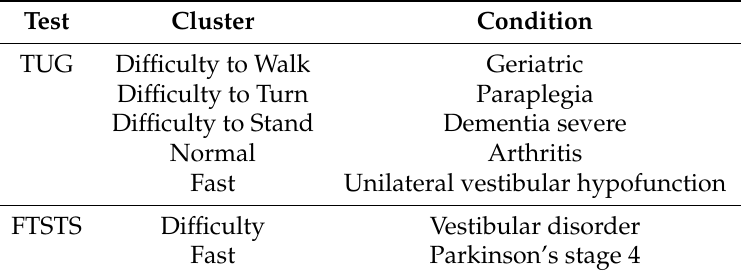
Table 4. Hybrid model most frequent association of difficulty and condition for the experimental test dataset of the eight